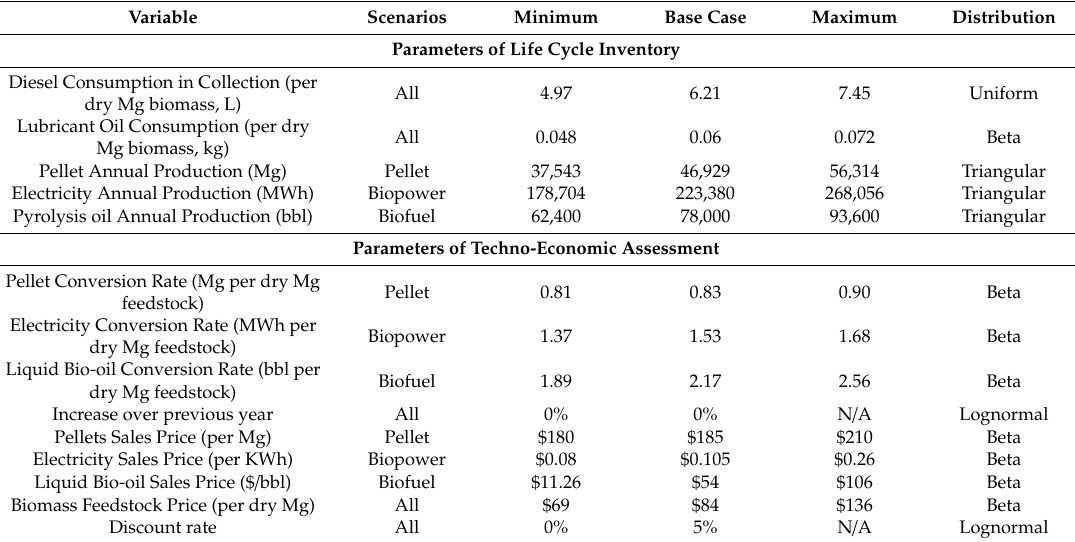
Table 2. Descriptions of parameters for uncertainty